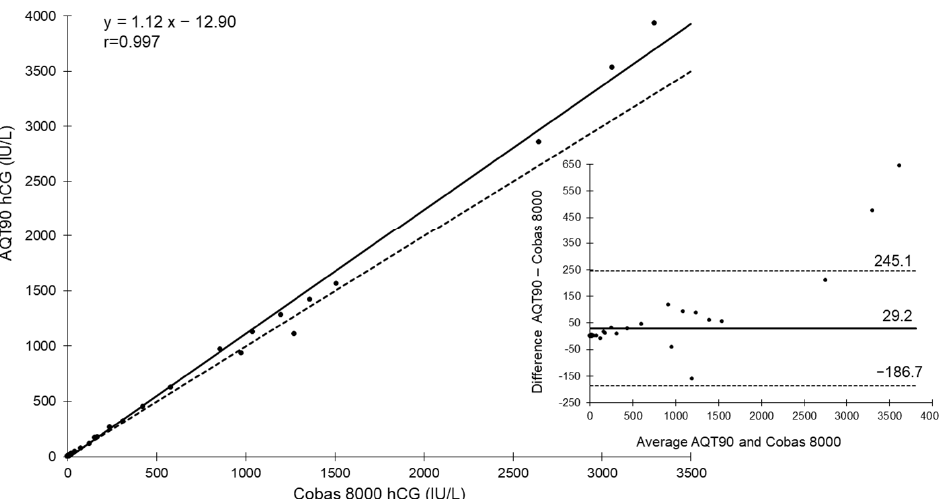
Figure 1. Deming regression ( n = 60) of hCG on e602/Cobas 8000 (plasma) and AQT90 (whole blood) in the central lab, and Bland–Altman plot of differences against means for patient samples with both analyzers. The Deming graph shows the regression line (solid line) and identity line (x = y, dashed line). For the Bland–Altman representation, the mean (solid horizontal line) and limits of agreement (dashed lines) of the bias (IU/L) were computed.